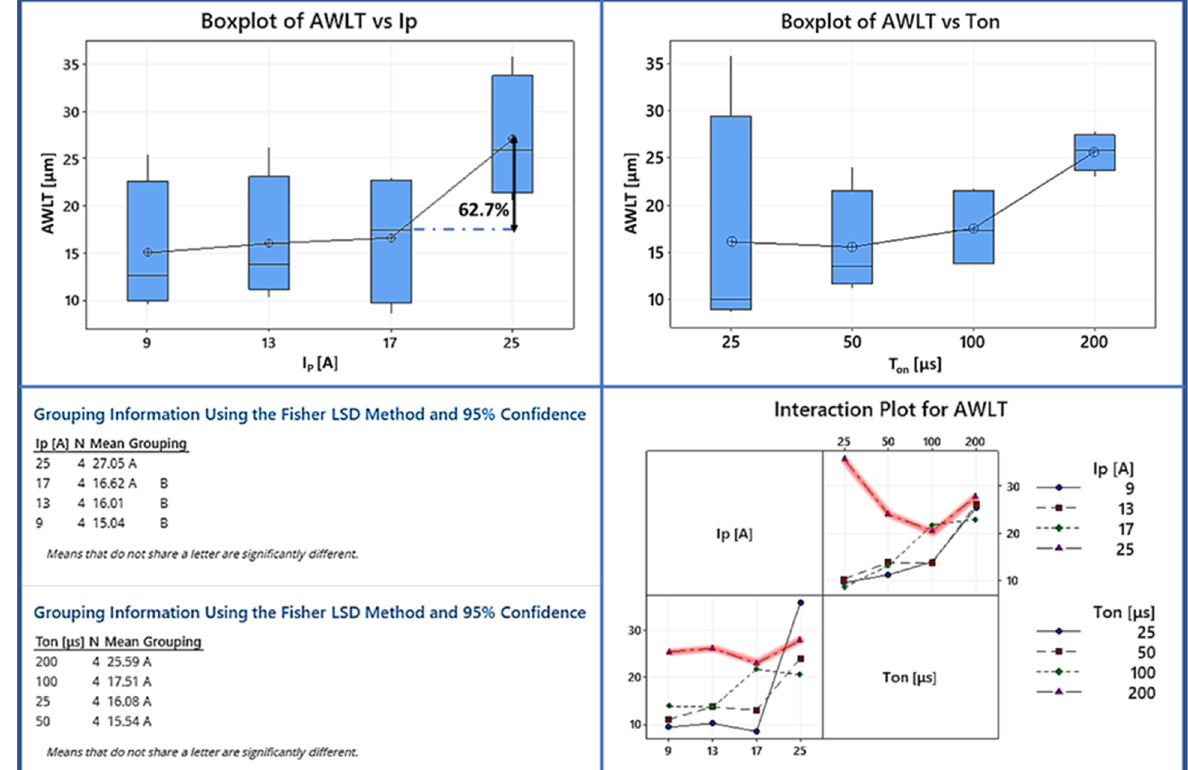
Figure 12. Analysis of the AWLT by using Fisher test, Box, and interaction plots.